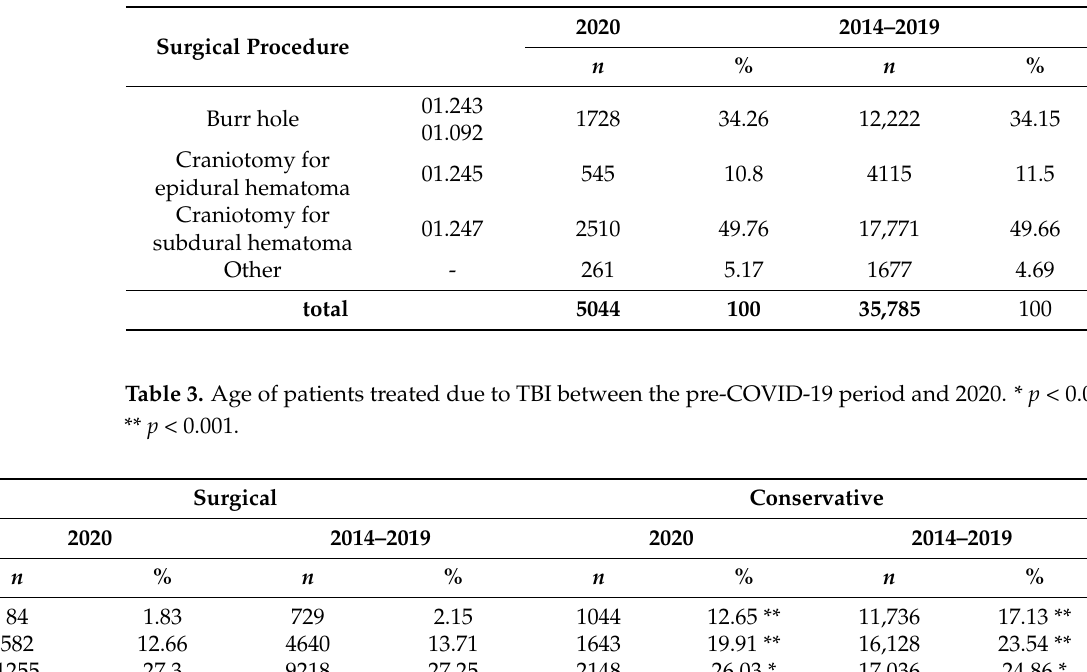
Table 2. Main surgical procedures during the COVID-19 pandemic and preceding years according to the ICD 9 classification.